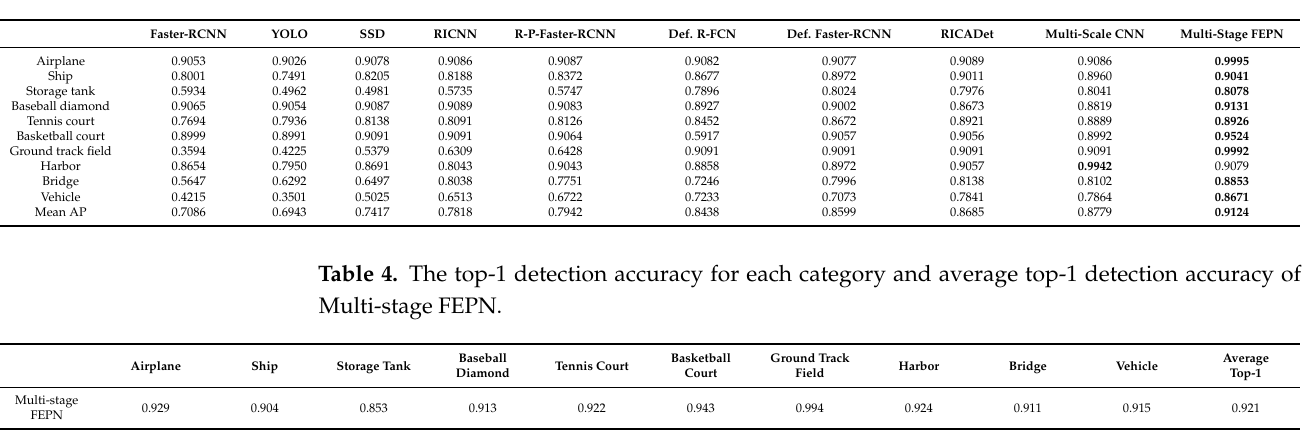
Figure 9. The P-R curves of different methods in the ablation experiment. ( a ) FPN; ( b ) FPN with CAFUS; ( c ) FPN with FEM; ( d ) Multi-stage FEPN. Table 2. The APs for each category of different methods and mAP in the ablation experiment. FPN FPN with CAFUS FPN with FEM Table 3. The APs for each category and mean AP of different frameworks.